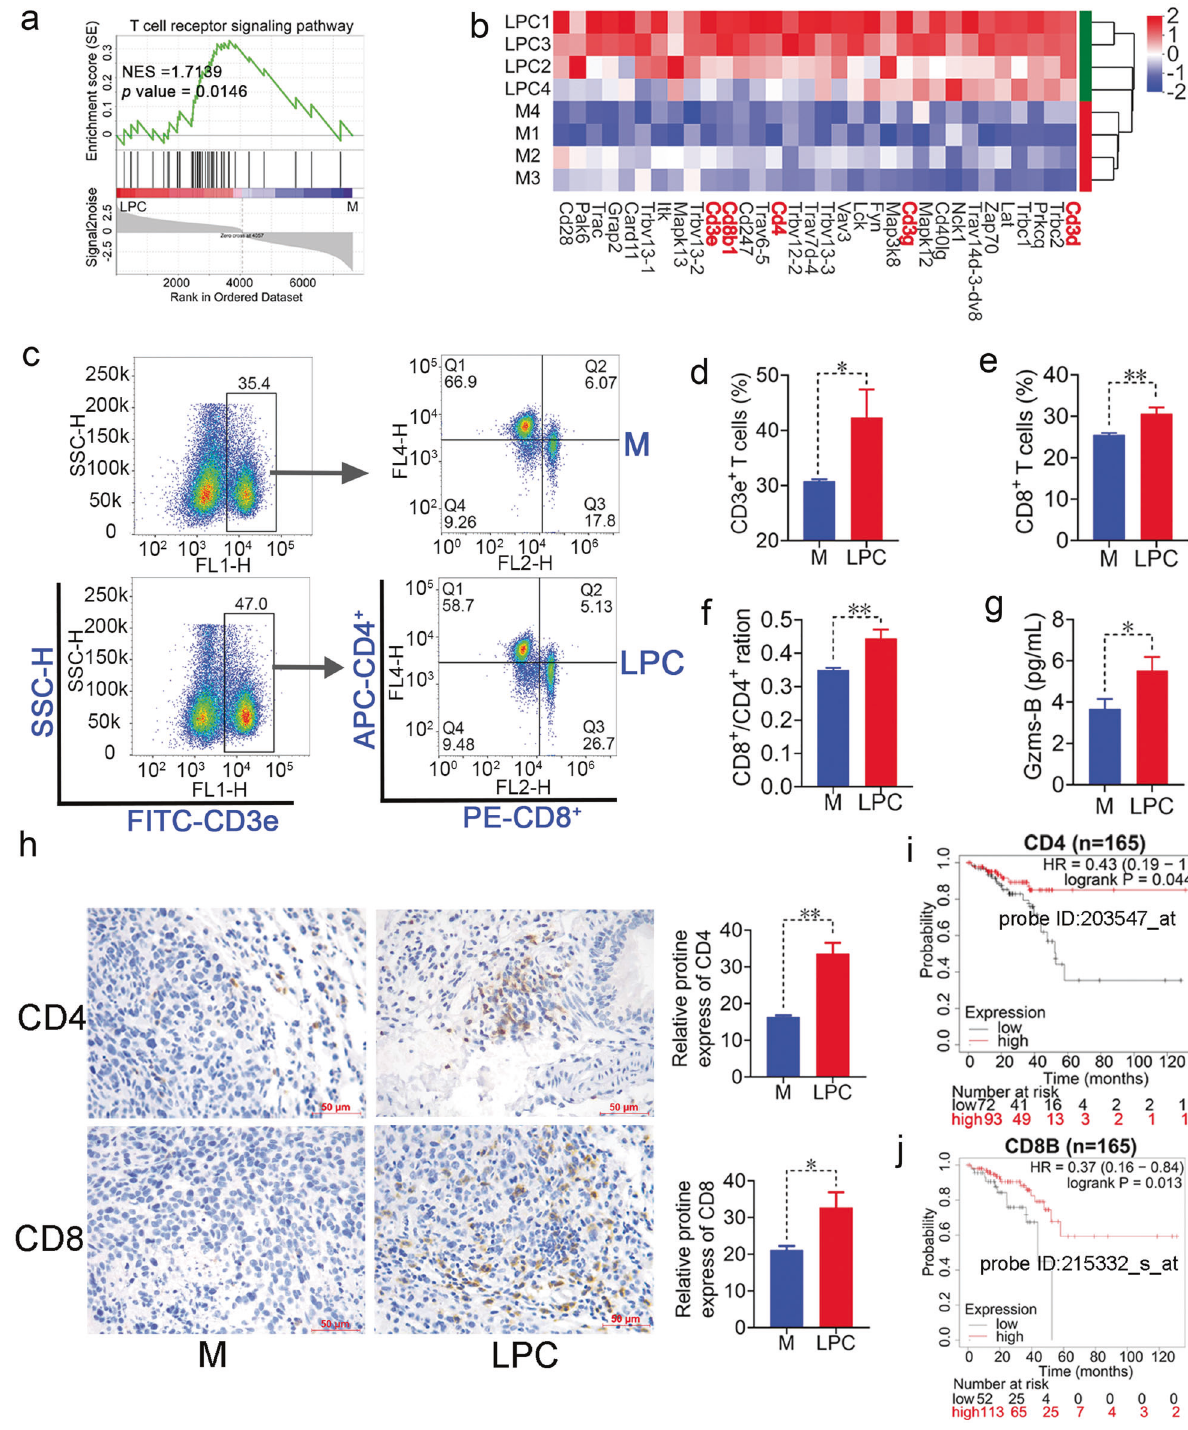
Fig. 3 LPC regulates T cell immunity in pulmonary metastasic mice. a GSEA based on T cell receptor signaling pathway. b Heatmap plot of gene set involved in T cell receptor signaling pathway. c T cells were detected by fl ow cytometry. d – f The relative amount of CD3e + T, CD8 + T, and the ratio of CD8 + /CD4 + ( n = 3 mice). g The serum level of Gzms-B ( n = 5 mice). h Representative IHC pro fi le of CD4 and CD8 in lungs ( n = 3 mice). 400× magni fi cation, scale bar = 50 µm. i , j Kaplan-Meier curves of the relationship between gene expression of CD4, CD8B and survival probability in colorectal cancer patients. Data were presented as mean ± SEM, * p < 0.05, ** p < 0.01. (Fig. 4o – q). These results indicated that LPC inhibited G - bacteria producing LPS, and suppressed in fl ammatory factors and TMAs accumulation in CT26 pulmonary metastatic mice.